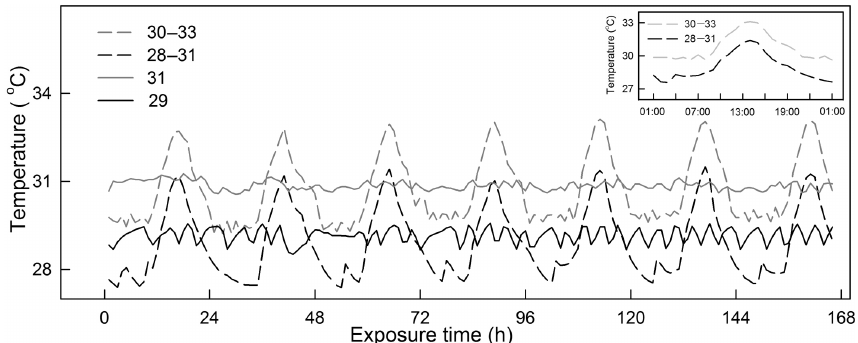
Figure 1. Temperature profiles for each treatment throughout the experiment. The inset shows the 1-day temperature trajectory in the two oscillating treatments. The time course in fluctuating treatments was 10h at minimum temperature, 5h of upward ramping, 2h at maximum temperature and 7h of downward ramping (passive).